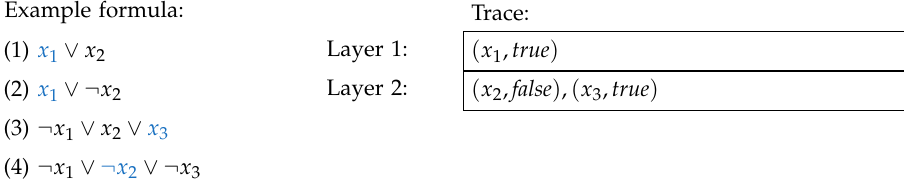
Figure 2. The assignments trace corresponding to the last search state in Figure 1. The first layer consists only of the decision variable x 1 . The second layer consists of the decision variable x 2 and the propagated variable x 3 . Literals colored in blue are true. As each clause has at least one true literal, the formula is satisfied by the current